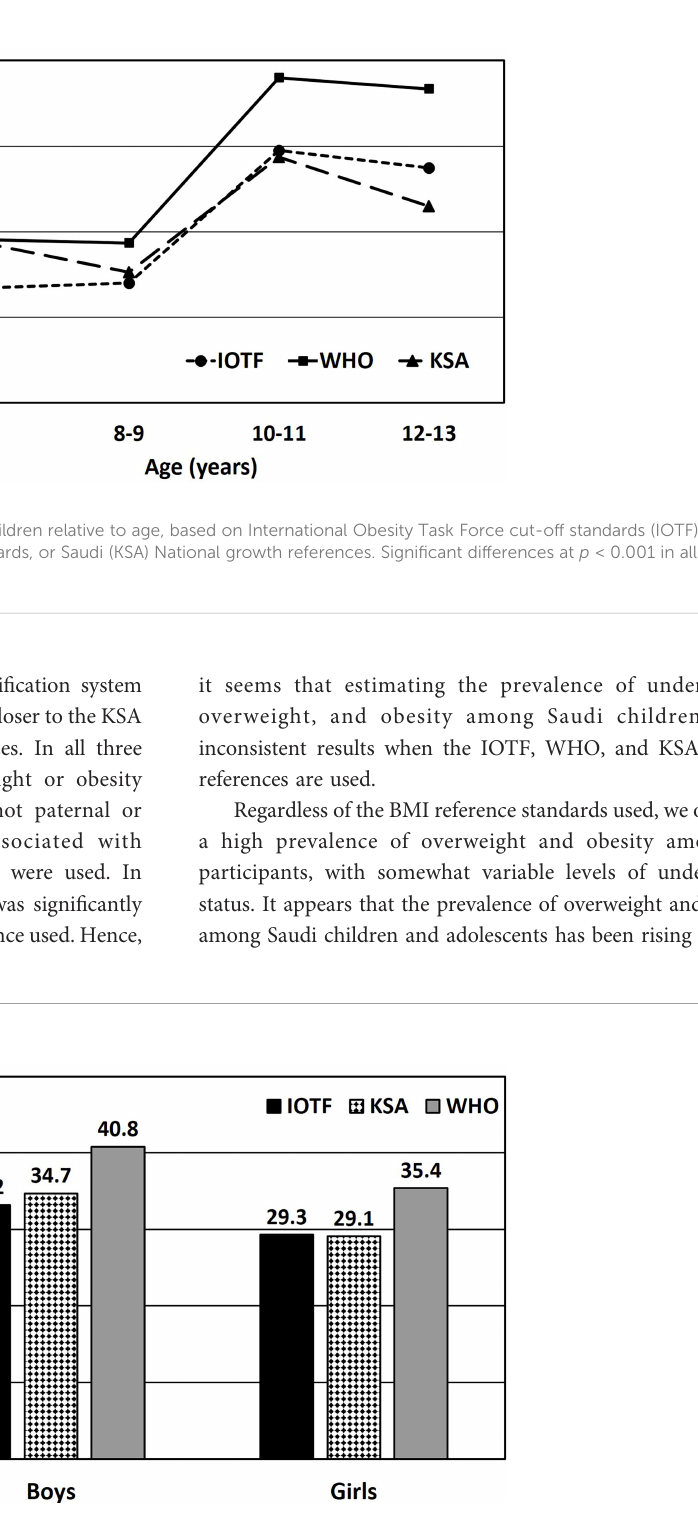
FIGURE 2 Overweight or obesity prevalence among Saudi children relative to sex, based on International Obesity Task Force cut-off standards (IOTF), World Health Organization (WHO) reference standards, or Saudi (KSA) National growth references. Signi fi cant differences between boys ’ and girls ’ reference standards ( p values for IOTF = 0.048, WHO = 0.009, and KSA =